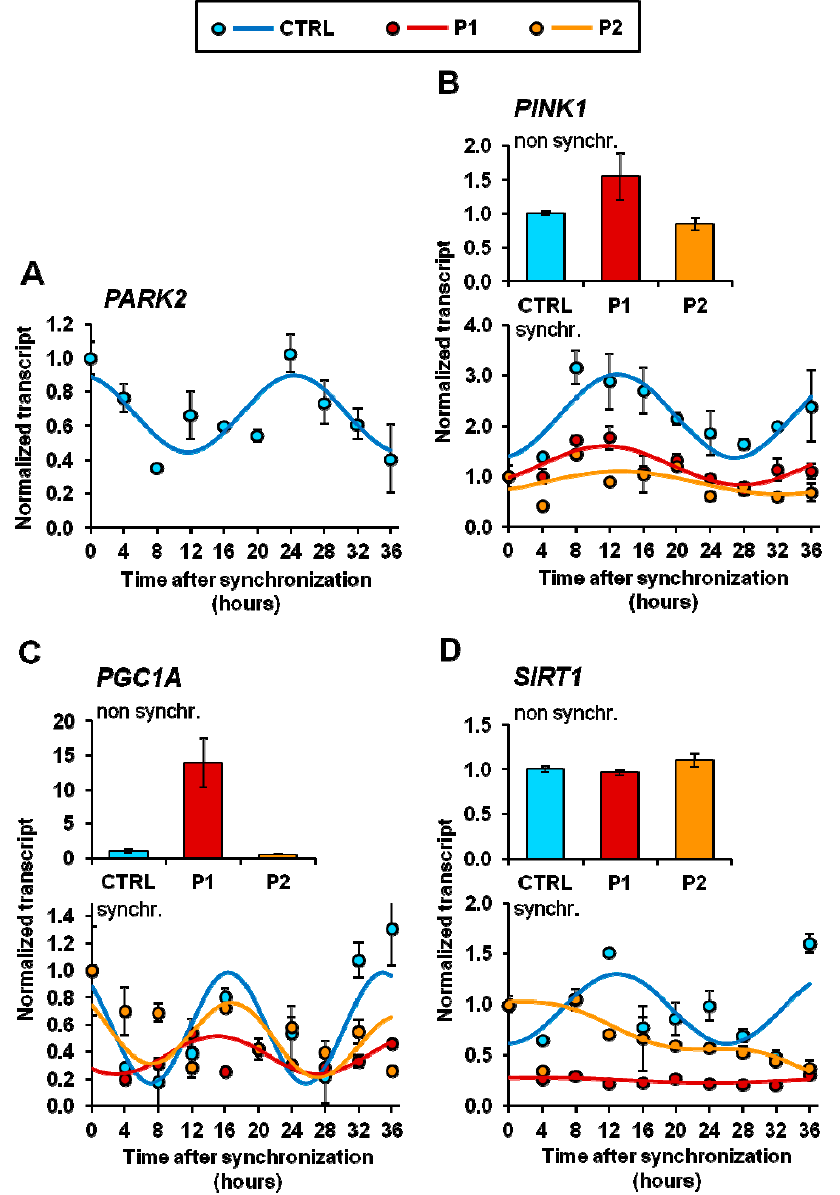
Figure 6. Transcription levels of PARK2 , PINK1 , PGC1A , and SIRT1 in normal (CTRL) and PD patient-derived (P1, P2) fibroblasts. The mRNA isolated from non-synchronized and serum shocked-synchronized fibroblasts were subjected to qRT-PCR analysis and the values of PARK2 ( A ), PINK1 ( B ), PGC1A ( C ), and SIRT1 ( D ) normalized to the housekeeping gene GAPDH. Data from non-synchronized cells were expressed as fold changes compared to CTRL cells. Data from synchronized cells are expressed as fold change compared to t = 0 and best fit with the COSINOR function. All the values shown are means ± SEM of two independent experiments performed in triplicate under each condition. See Materials and Methods for experimental